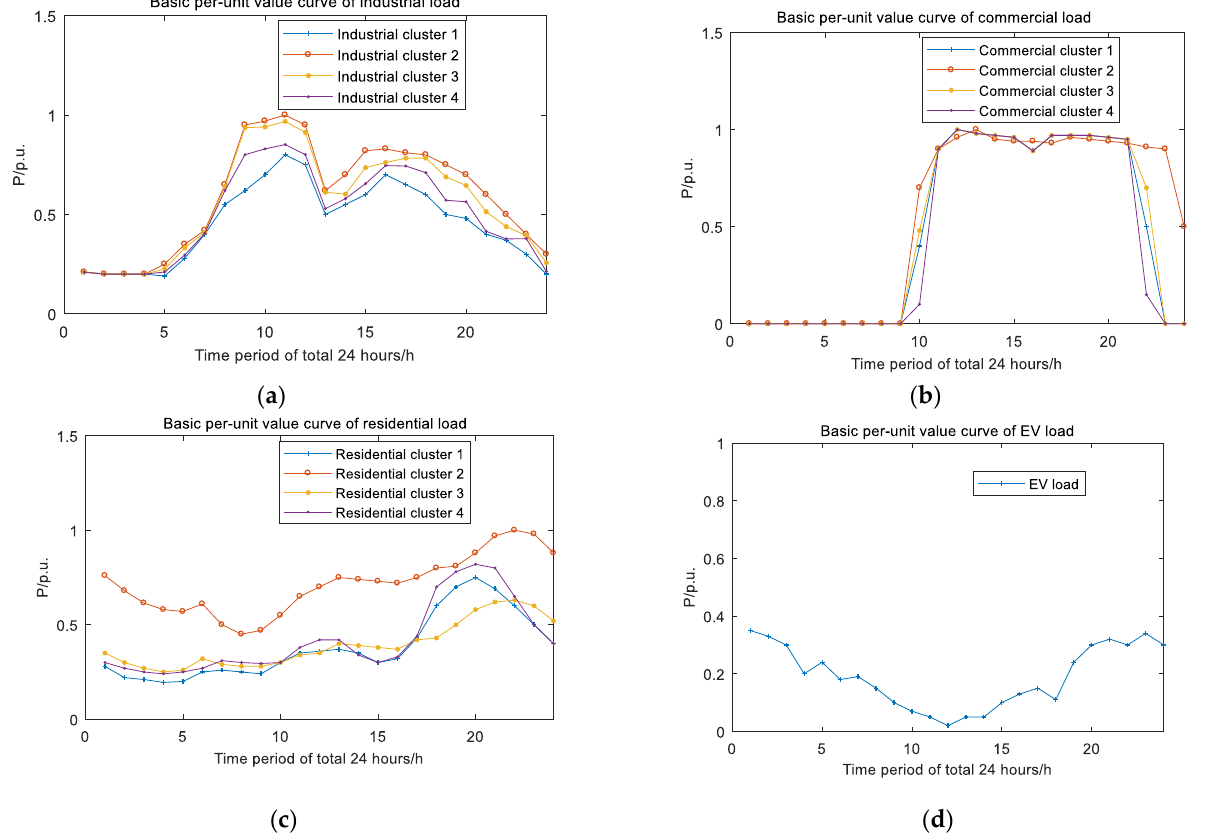
Figure 13. The basic per-unit value curve of industrial, commercial and residential load. ( a ) Industrial load; ( b ) Commercial load; ( c ) Residential load; ( d ) EV load.